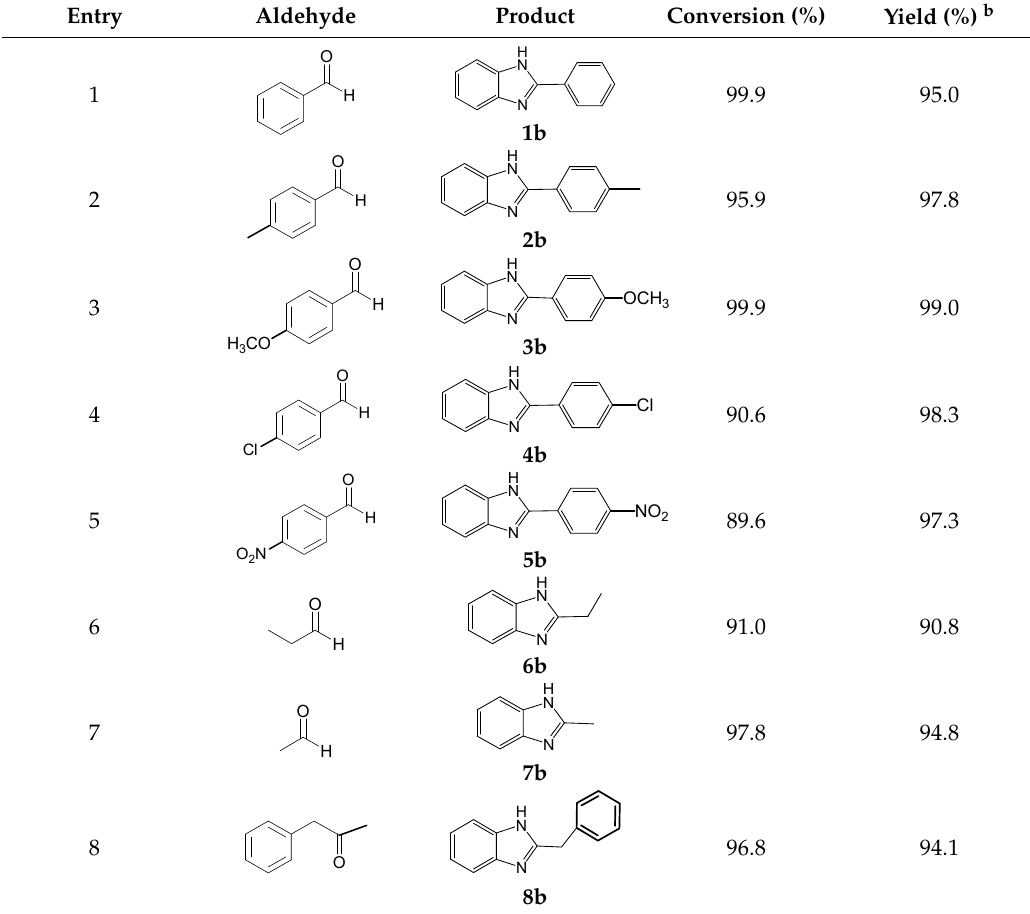
Table 3. Synthesis of 2-monosubstituted benzimidazoles. a